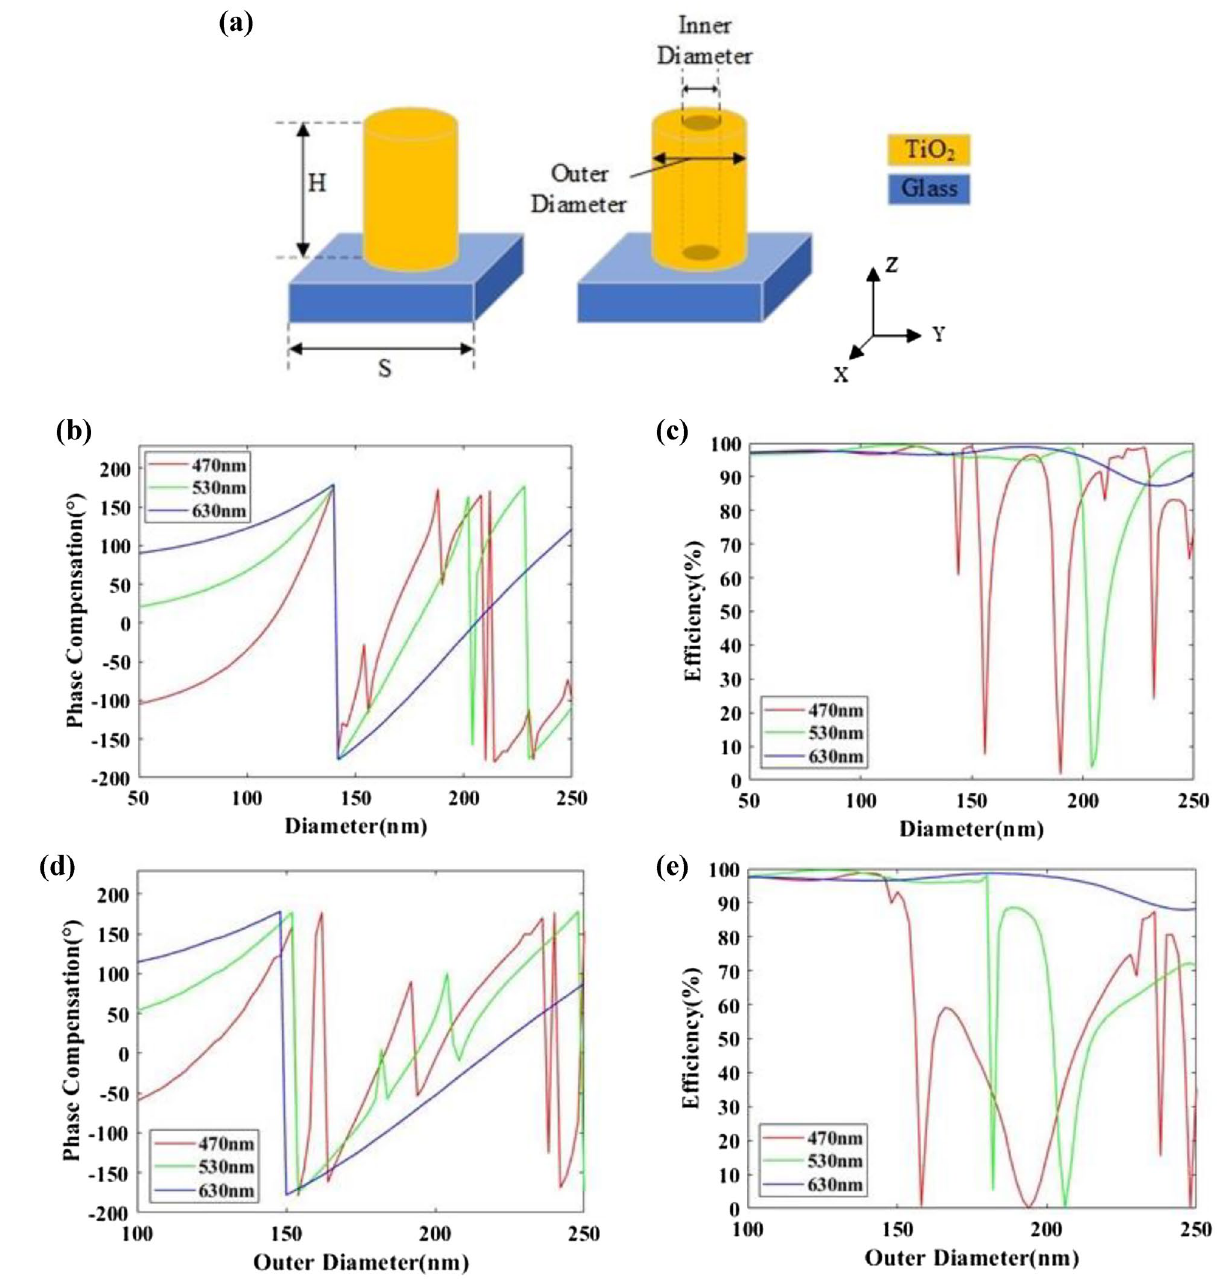
Figure 4. ( a ) Schematic of the nanostructures in focusing layer. The TiO 2 nanopillar is placed on a glass substrate. ( b , c ) Phase compensation and efficiency with the change of diameter of cylindroid nanopillars at the wavelengths of 470 nm, 530 nm and 630 nm, respectively. ( d , e ) Phase compensation and efficiency with the change of outer diameter and the inner diameter of 50 nm of annular nanopillars at the wavelengths of 470 nm, 530 nm and 630 nm,